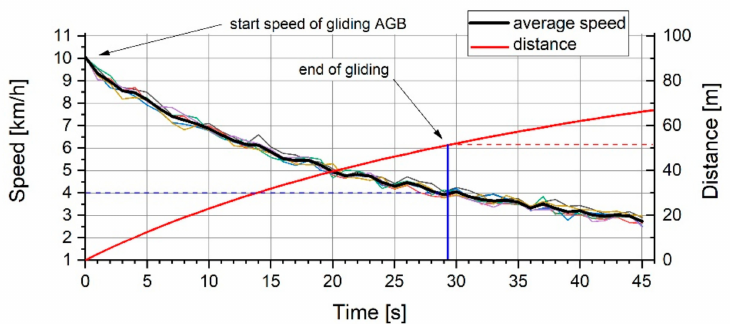
Figure 6. Graphs of instantaneous velocity and distance covered as a function of time for a ferry moving with the propulsion turned o ff , i.e., during gliding.